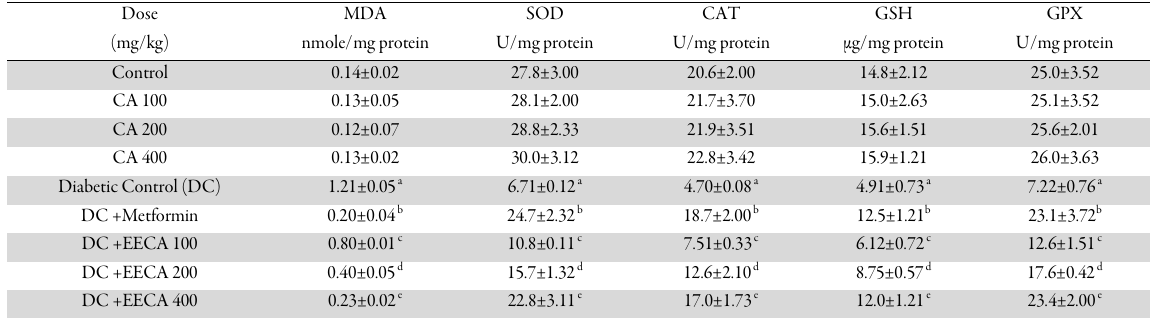
Table 9. Effect of Chrysophyllum albidum on pancreas oxidative stress markers of alloxan- induced diabetic rats